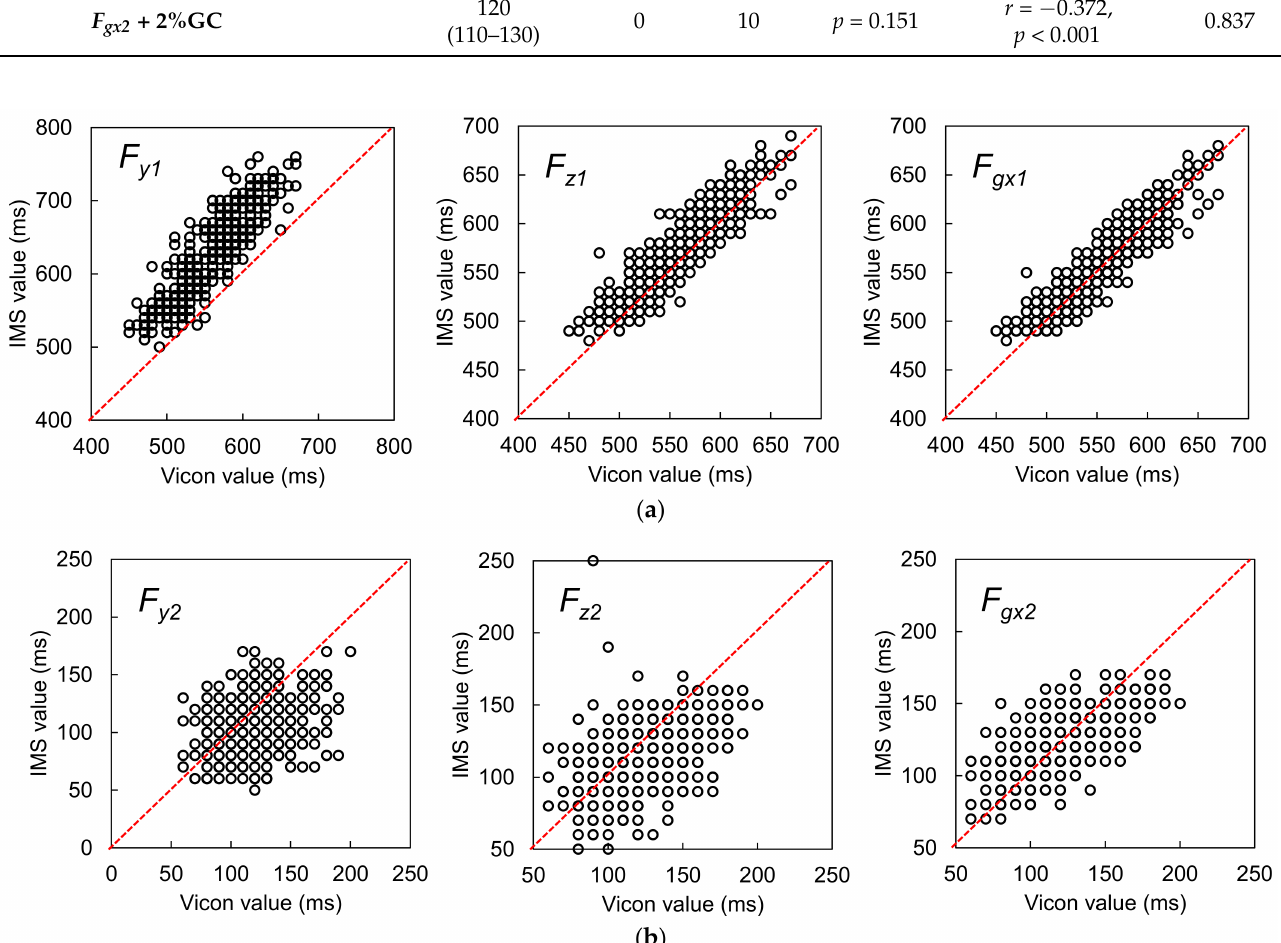
Figure 9. ( a ) Agreement plots for the candidate features for OHS detection, and ( b ) agreement plots for the candidate features for OTO detection. The red dotted lines represent the PA